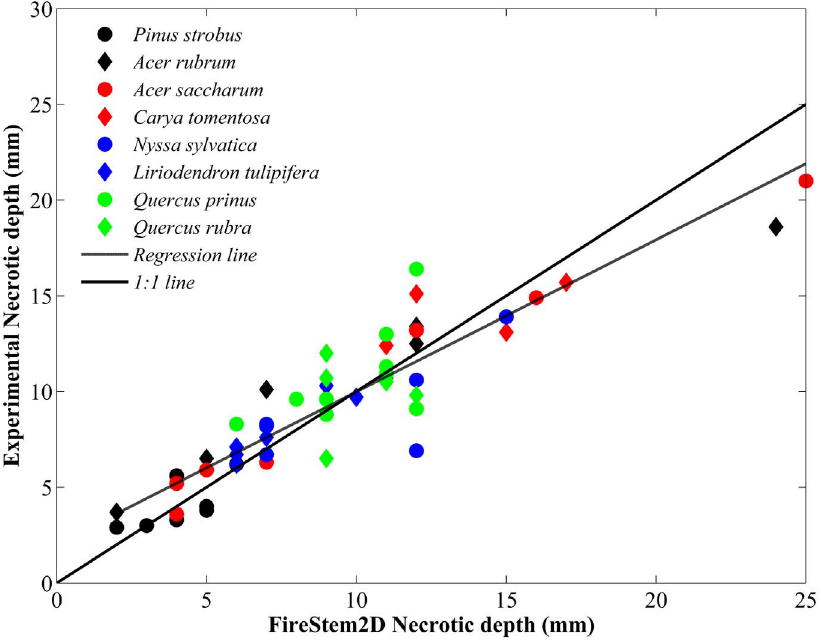
Figure 6. Scatter-plot of necrotic depth of 52 tree sections from 25 trees of 8 different species from the heating experiments (Table 1) compared with the simulated necrotic depth estimated with FireStem2D. Dashed line marks the overall model-observation fit, solid line marks the ideal (1:1) model-observation relationship (regression line y=1.051( 6 0.1325)x 2 0.6044( 6 1.3612), R 2 =0.84). Regression line and 1:1 line are not significantly different, proving the very good prediction of necrotic depths.